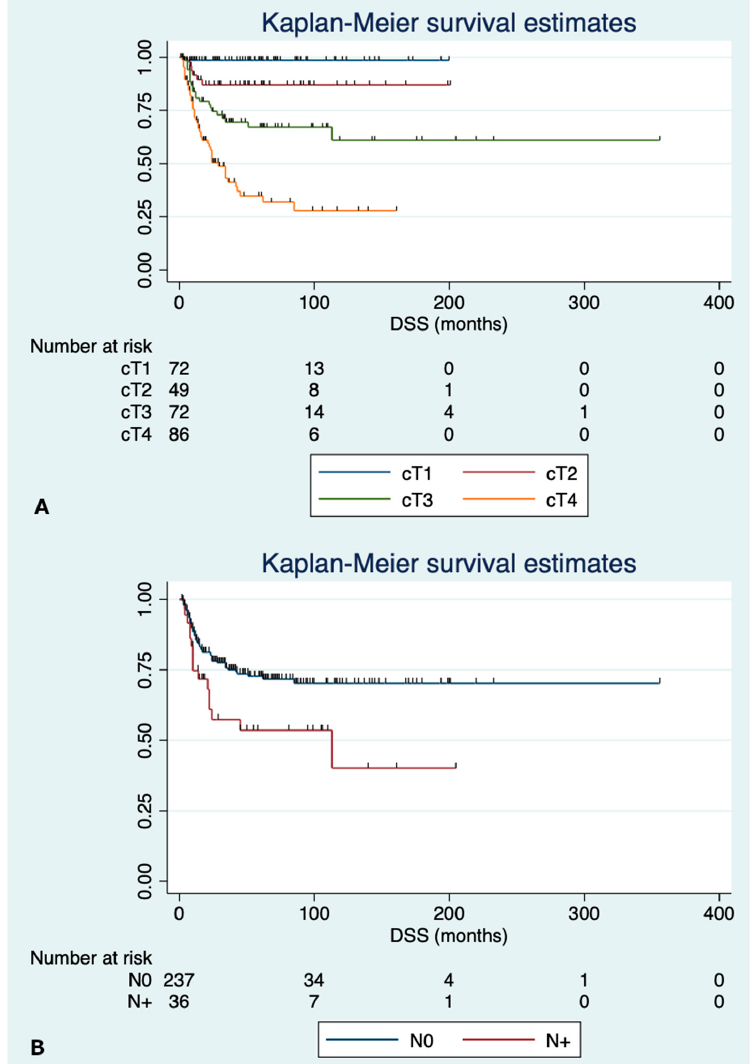
Figure 2. Disease-specific survival according to cT category ( A ) and N status ( B ). Results of pooled univariable and multivariable analyses are reported in Tables 3 and 4. Advanced tumor categories (cT3 and cT4) were independent prognostic factors for OS Table 3. Univariate and multivariable analysis of pooled data for OS. (HR = 2.65 95% CI, 1.34–5.22; HR = 5.51 95% CI, 2.76–10.5, respectively) and DSS (HR = 23.8 95% CI, 3.20–177.8; HR = 56.0 95% CI, 7.67–409.1, respectively). Variable